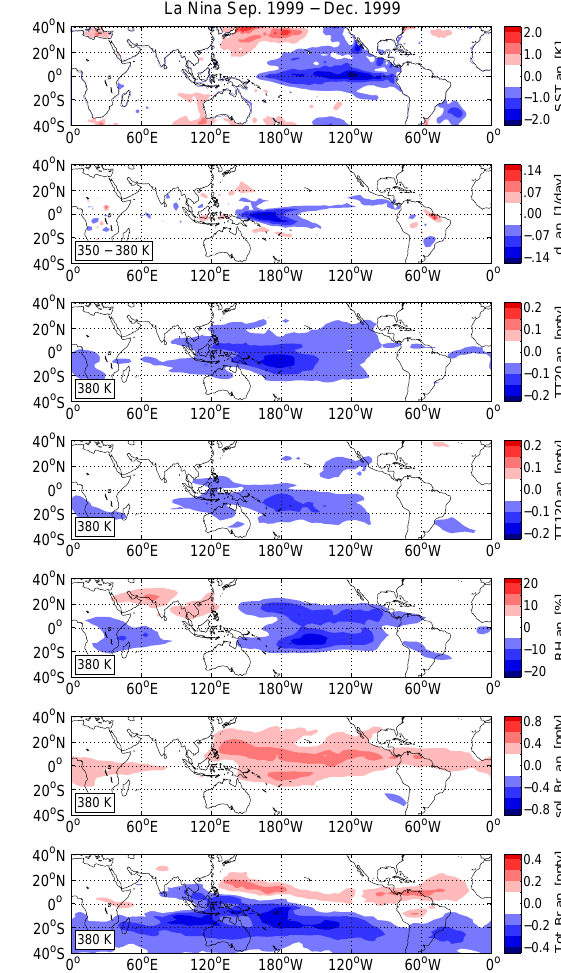
Fig. 9. Averaged anomalies of sea surface temperature SST, detrainment rate d c , idealized bromoform tracer TT20, idealized dibro- momethane tracer TT120, relative humidity RH, soluble Br y and total bromine. The small boxes denote the corresponding potential temper- ature level. Left: Averages over El Ni˜no season November 1997 to February 1998. Right: Averages over La Ni˜na season September 1999 to December